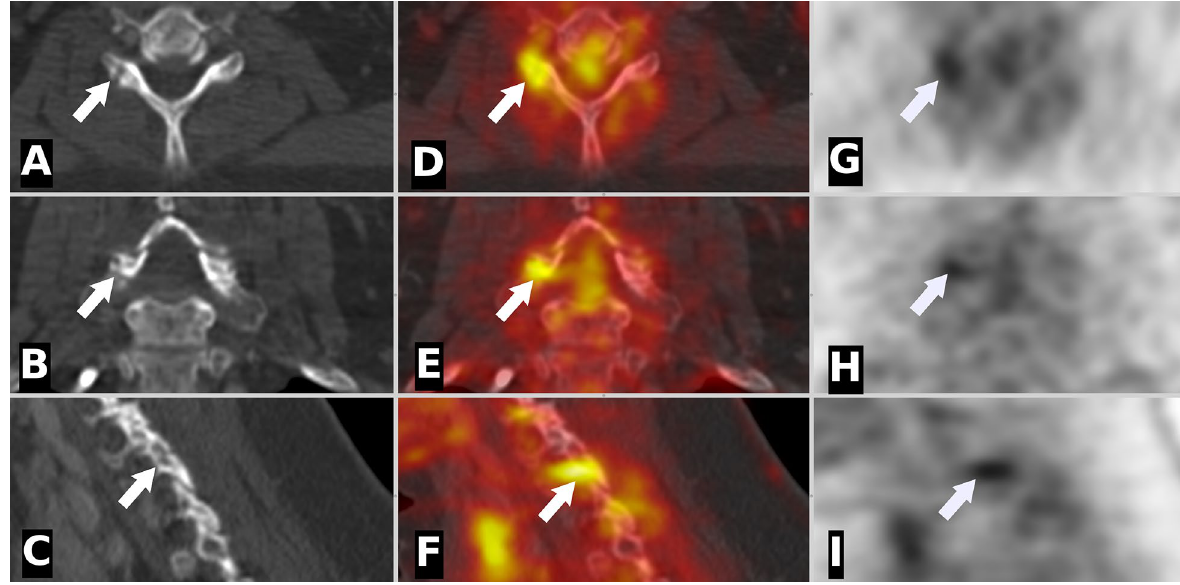
with no underlying CT changes. The pain has been improved after facet injection therapy at this level